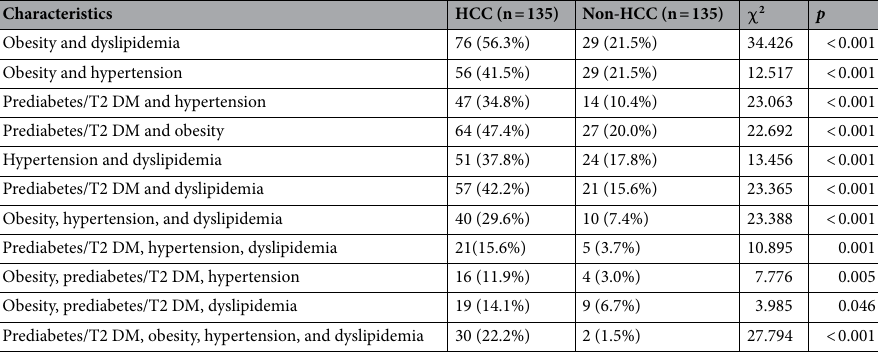
Table 3. Types of metabolic traits of patients with MAFLD and MAFLD-HCC. T2 DM, Type II diabetes.